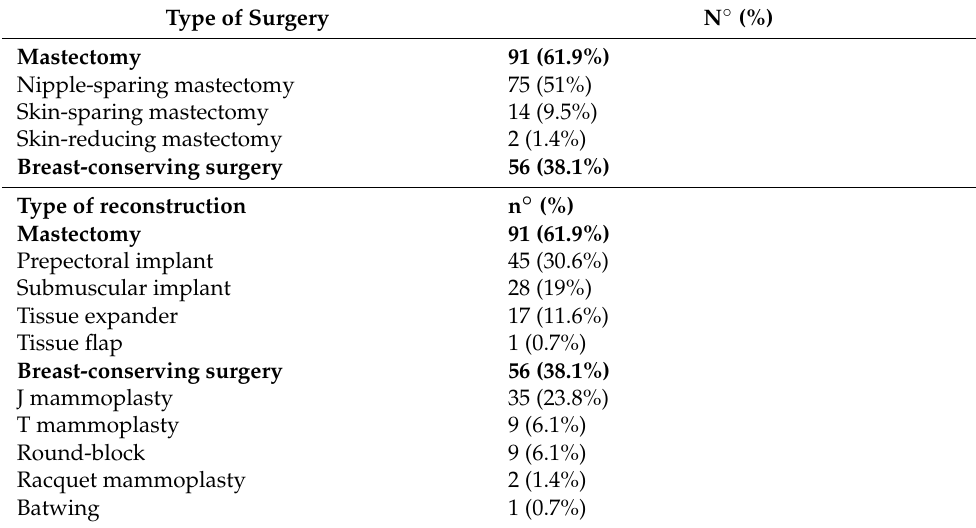
Figure 1. Patient Accrual. Table 1. Type of Surgery and Breast Reconstruction.